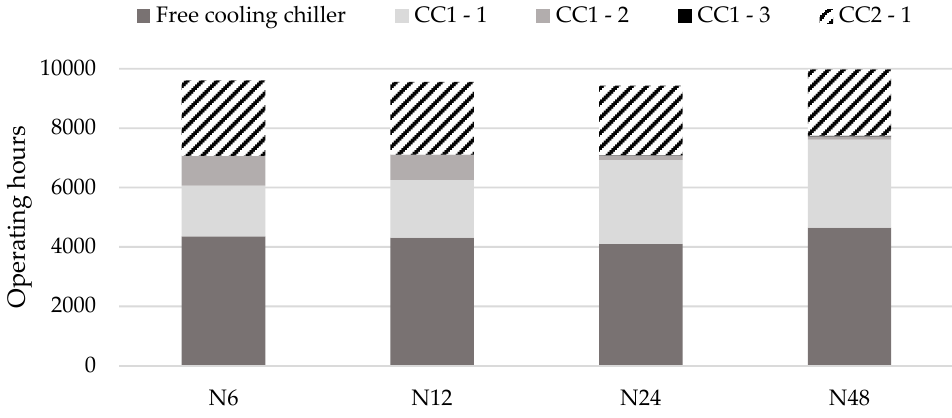
Figure 5. Operating hours of chillers in different stages for varying prediction horizons.